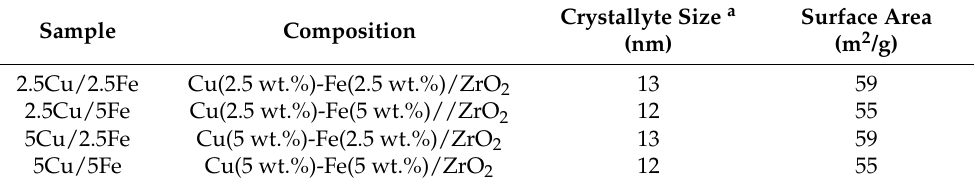
Table 1. Composition and surface area of investigated